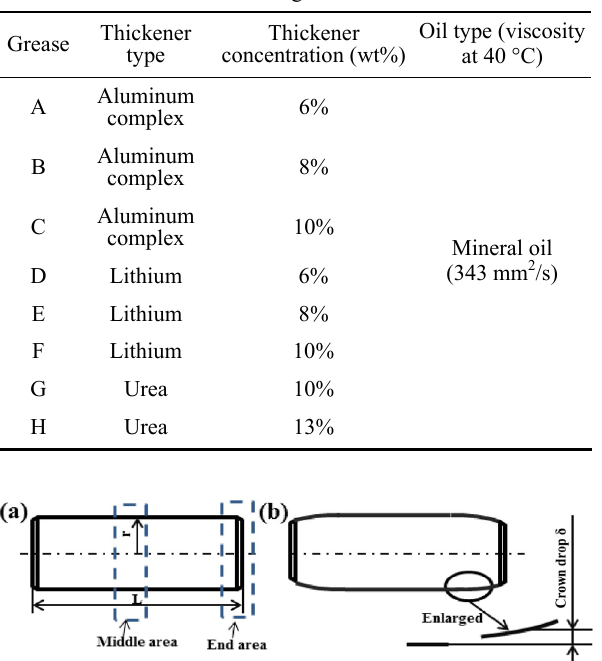
Table 1 Formulation of tested greases.